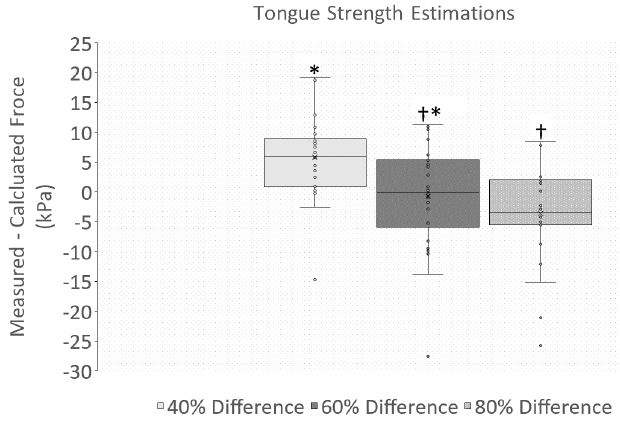
Figure 1. Calculated differences for exercise intensities for combined data of instrumentalists and controls. † p < 0.05 compared to the 40% differences. * p < 0.05 compared to the 80% differences. The upper bounds represent the upper (75th percentile + 1.5 * interquartile range) and lower (25th percentile—1.5 * interquartile range) quartiles.